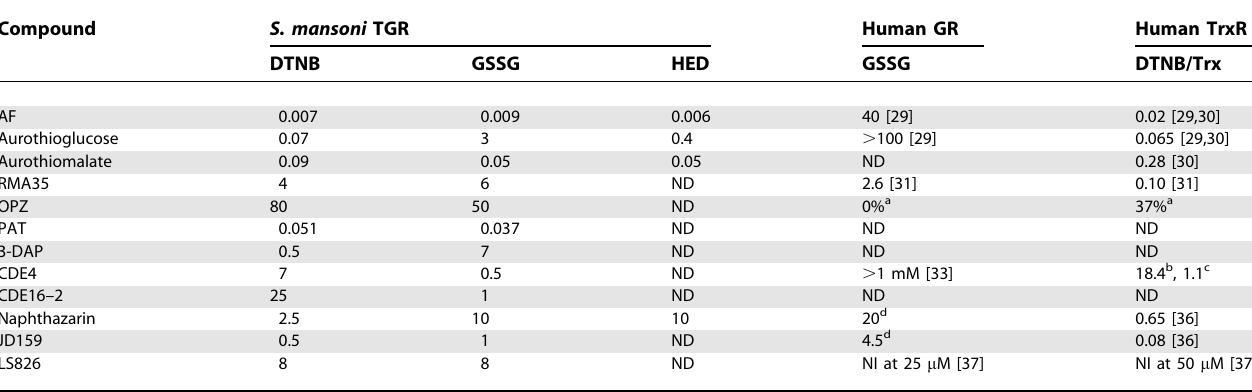
Table 4. IC 50 Values of TGR Inhibitors with 15-Minute Preincubation Assays